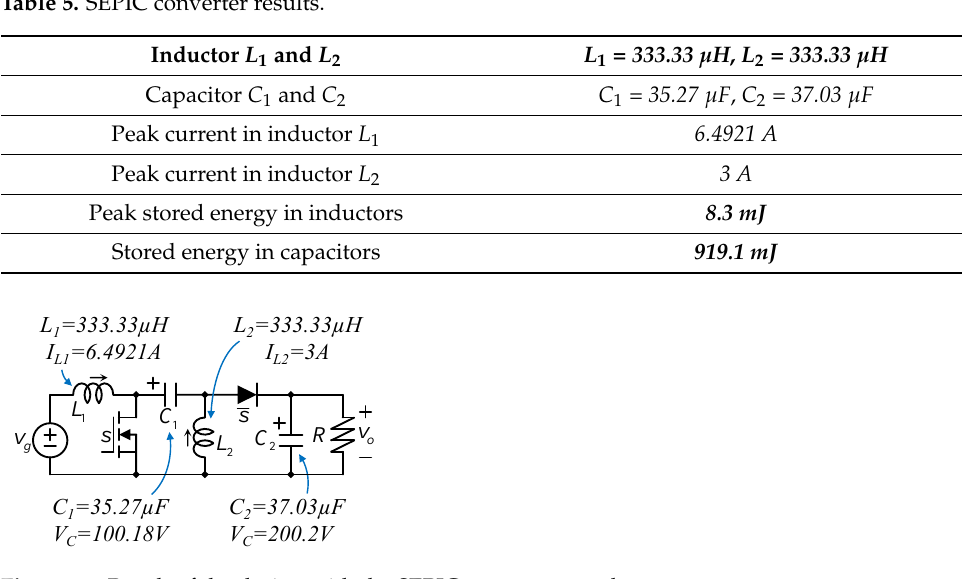
Figure 15. Result of the design with the SEPIC converter topology.